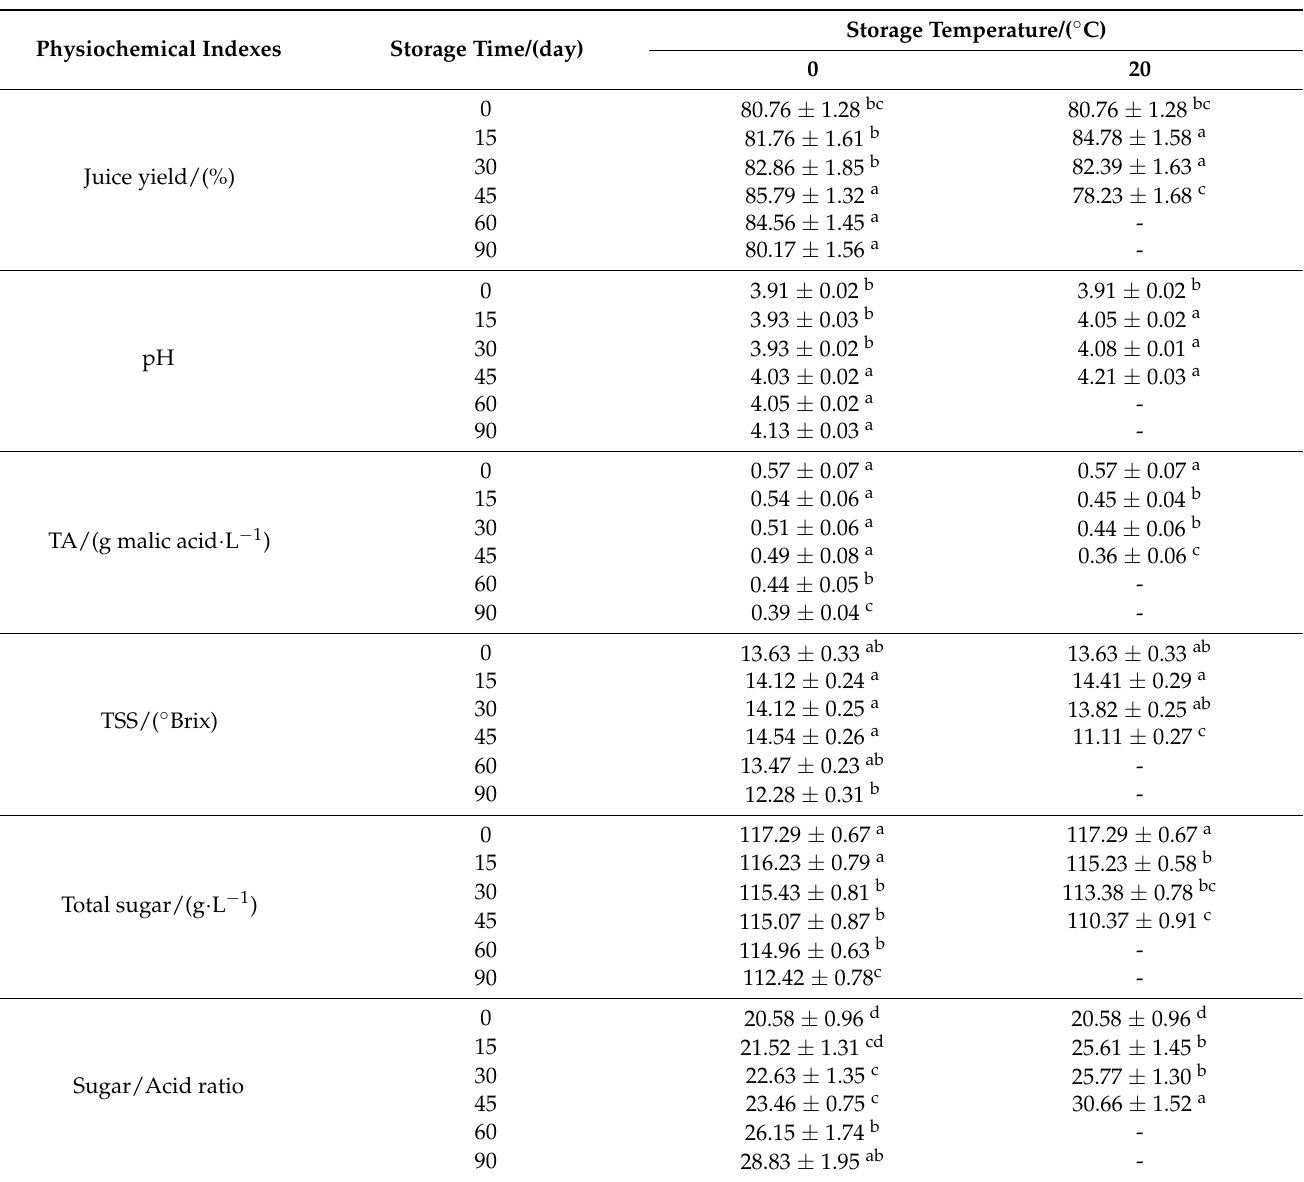
Table 1. Juice yield, pH, titratable acids (TA), total soluble solids (TSS), and sugar/acid ratio (mean ± S.D.) for cloudy apple juice come from fruit storage under different temperature (0, 20 ◦ C) and time (0, 9, 18, 30, 60